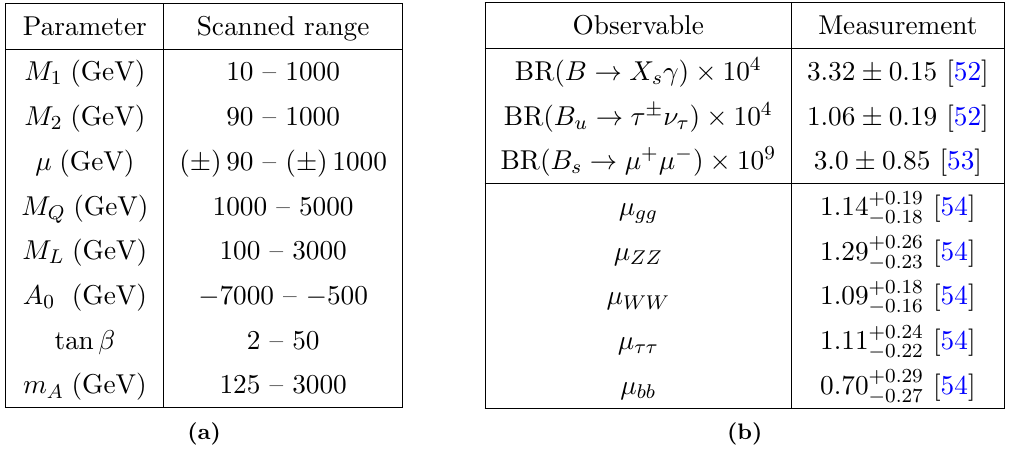
Table 1. (a) MSSM parameters and their scanned ranges. (b) Experimental observables and their measured values, imposed as constraints on the scanned